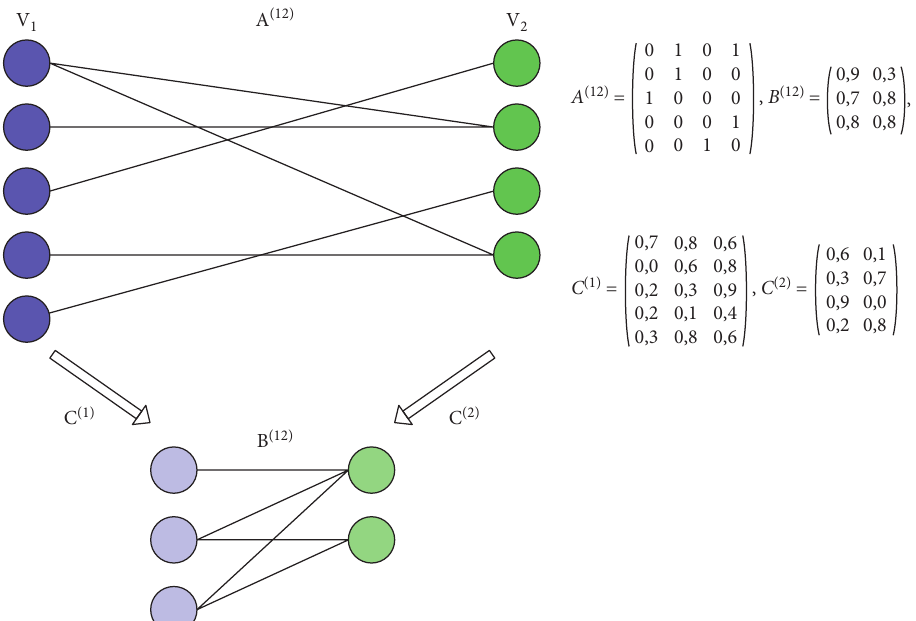
Figure 3: Matrix illustration on fuzzy K-partite clustering